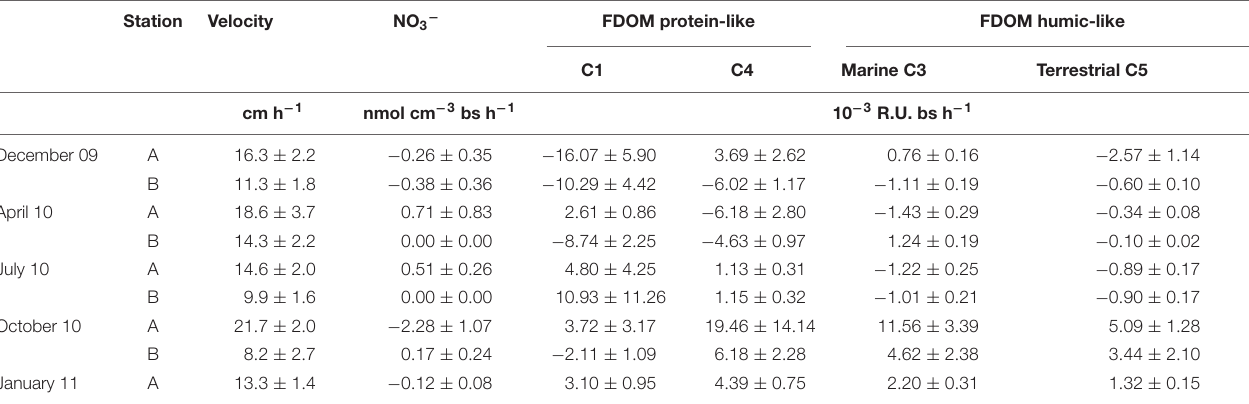
TABLE 1 | NO 3 − and FDOM reaction rates calculated through mass balances of solute distribution in the top 44 cm of sediment in the seepage face, organized by survey and sampling station. Station Velocity NO 3 − FDOM protein-like FDOM